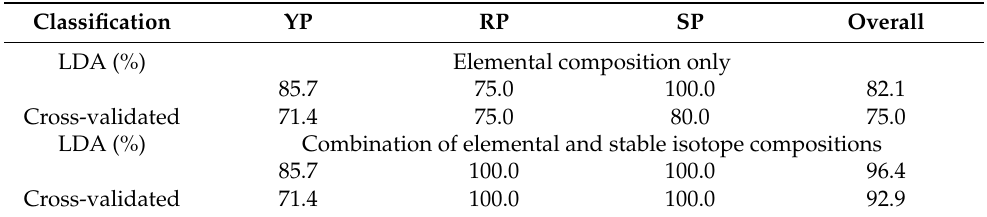
Table 2. Classification of THMR according to the provinces of origins using linear discriminant analysis (LDA) based on each composition.